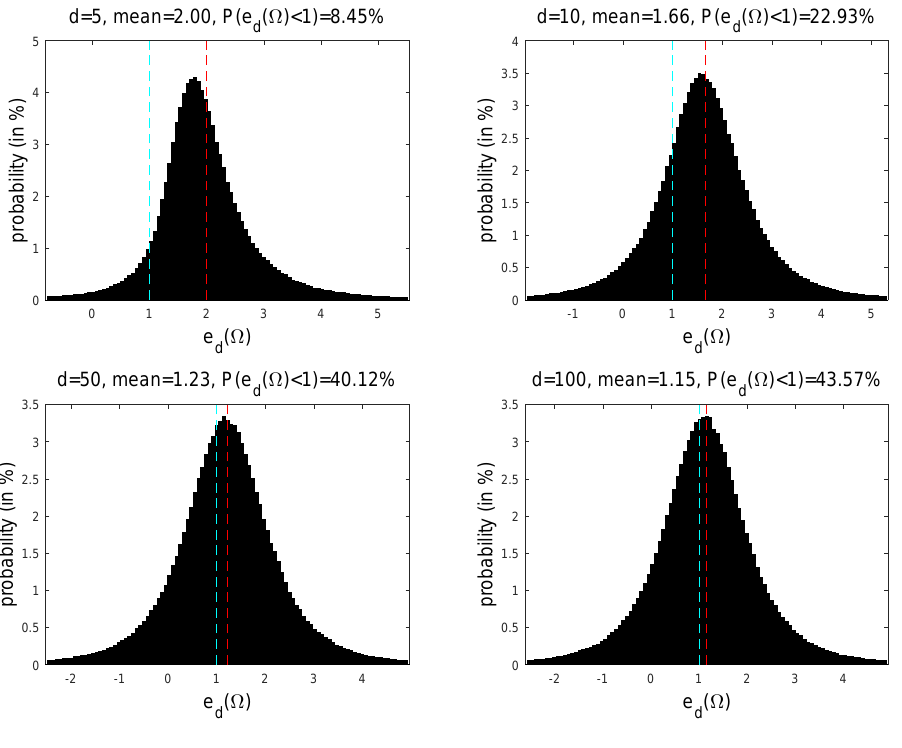
Figure 2: Histogram of the probability distribution of e d ( Ω ) with Ω ∼ U ( C d ) based on n = 1, 000, 000 simulations, for d ∈ { 5, 10, 50, 100 } . The vertical, red line gives the mean, and the blue line represents the border 1 between over- and un- derrepresentation of the non-central